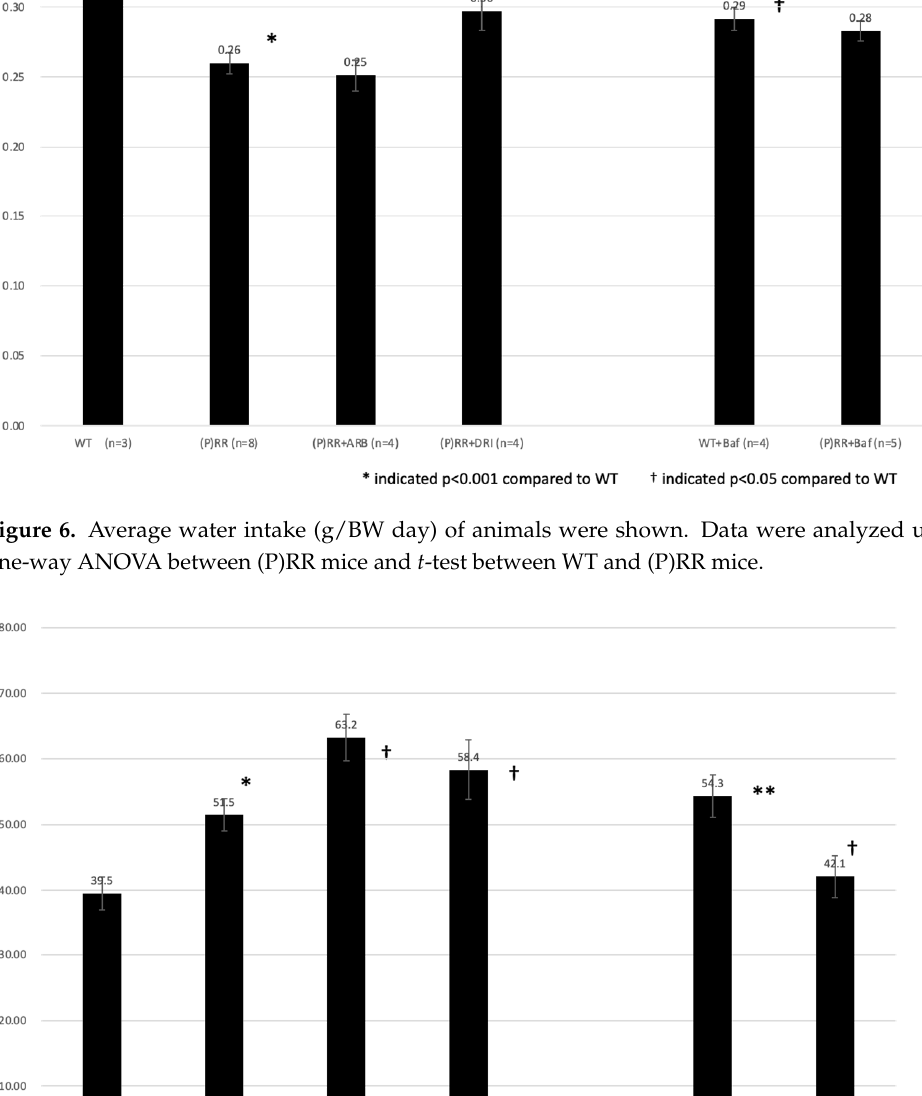
Figure 8. Average urine pH of animals is shown. Data were analyzed using one-way ANOVA be- tween (P)RR mice and t -test between WT and (P)RR mice. Urine osmolality was lower in (P)RR-TG mice than in WT mice (2787.8 ± 161.5 mOsm/kg vs. 4043.3 ± 398.1 mOsm/kg, p < 0.05) (Figure 9). ARB, DRI, and bafilomycin administration did not significantly affect urine osmolality in (P)RR-TG mice (2613.8 ± 205.7 mOsm/kg vs. 2787.8 ± 161.5 mOsm/kg, 2719.2 ± 268.9 mOsm/kg vs. 2787.8 ± 161.5 mOsm/kg, and 2839.4 ± 268.9 mOsm/kg vs. 2787.8 ± 161.5 mOsm/kg, respectively; p = n.s.). Bafilomycin administration did not significantly affect urine osmolality in WT mice (2922.3 ± 334.7 mOsm/kg vs. 4043.3 ± 398.1 mOsm/kg, p = n.s.).